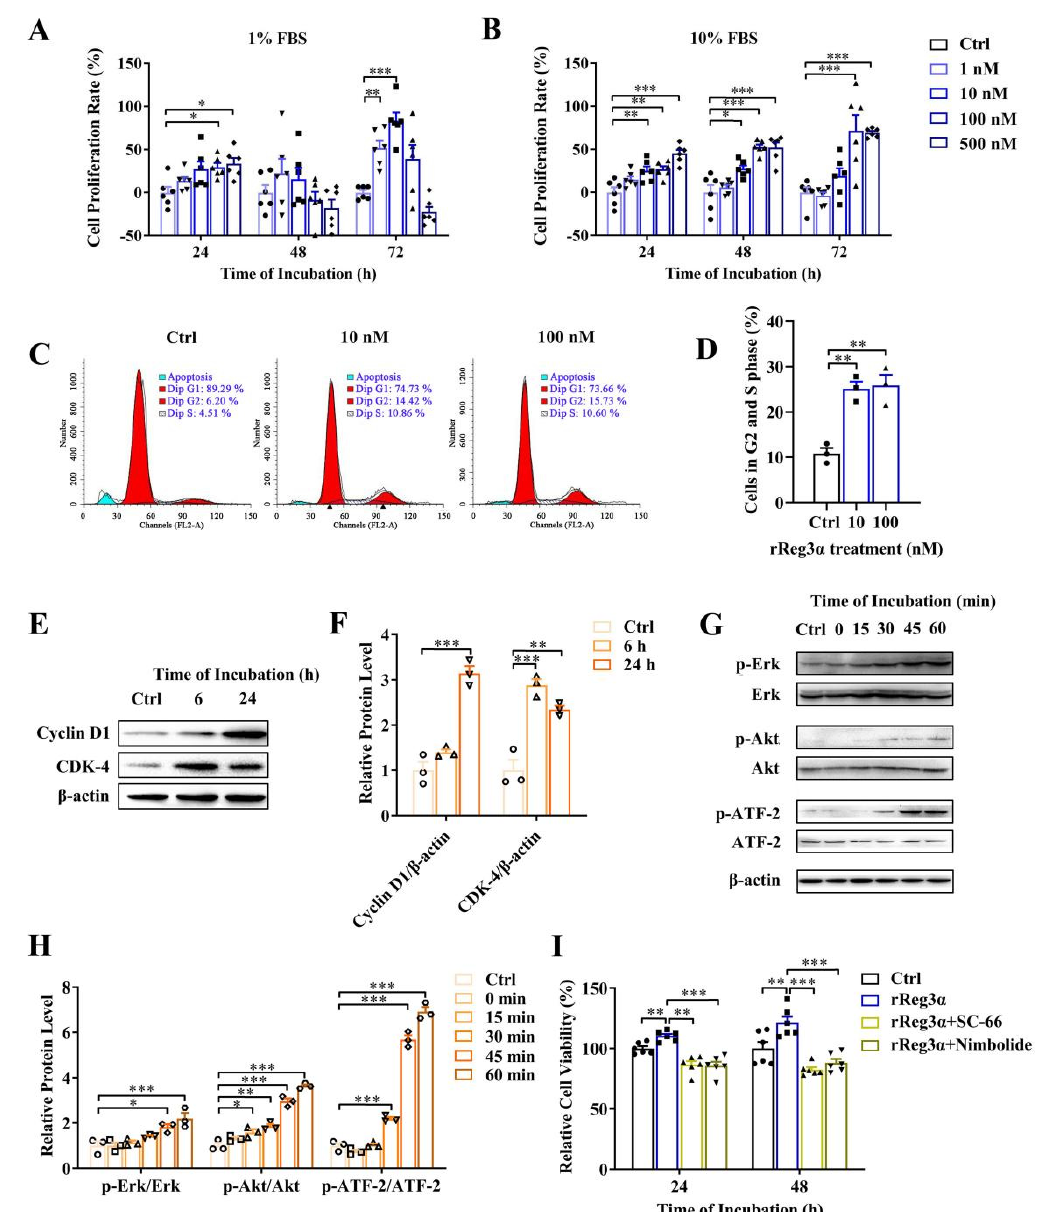
Figure 1. rReg3 α stimulates MIN6 cell proliferation. ( A ) MTT test in MIN6 cells treated with a gra- dient concentration of rReg3 α in 1% FBS. ( B ) MTT test in 10% FBS. * p < 0.05, ** p < 0.01, and *** p < 0.001 using one-way ANOVA, N = 6. ( C ) Cell cycle assay in MIN6 cells treated with rReg3 α . Cells in S and G2 phases were considered proliferative. ( D ) Statistics of the proportion of proliferating cell in panel C. ** p < 0.01 using one-way ANOVA, N = 3. ( E ) Western blotting of CDK4 and cyclin D1 levels. ( F ) Densitometric quantification of the protein levels in panel E. The relative protein con- tents were corrected by β− actin. ** p < 0.01 and *** p < 0.001 using one-way ANOVA, N = 3. ( G ) Western blo tt ing of Erk, Akt, and ATF − 2 phosphorylation. ( H ) Densitometric quantification of the phosphorylated protein levels in panel G. The relative protein levels were corrected by the corre- sponding total proteins. * p < 0.05, ** p < 0.01, and *** p < 0.001 using one-way ANOVA, N = 3. ( I ) MTT test in MIN6 cells treated with rReg3 α and inhibitors against Akt (SC − 66) or Erk (Nimbolide). ** p < 0.01 and *** p < 0.001 using one-way ANOVA, N = 6. 2.2. rReg3 α Protects MIN6 Cells from STZ-Induced Cell Apoptosis The effect of rReg3 α in β -cell protection was also investigated in MIN6 cells. In a challenge with STZ, the remaining healthy cells took less than 20% of the total cell number, which was rescued to 51% by rReg3 α treatment. Reduction of late apoptotic (from 44% to 11%) and necrotic cells (from 13% to 1%), while accumulation of early apoptotic cells (from